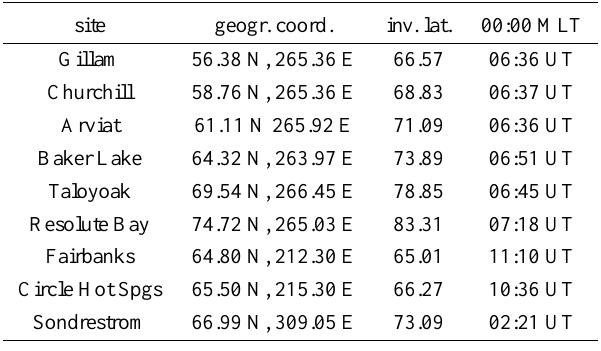
Table 1. Northern Hemisphere locations of LF/MF/HF receivers.